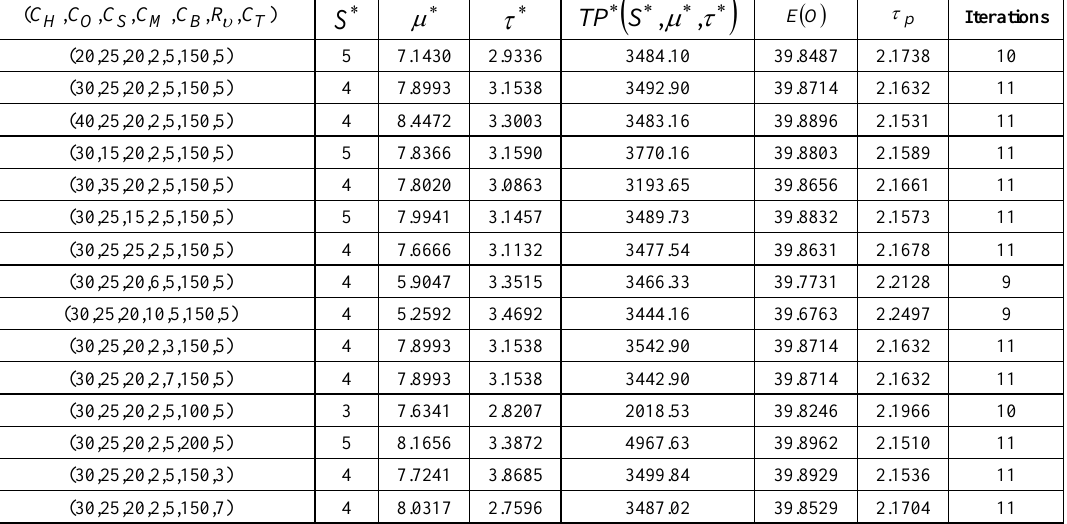
Table 13. Optimal profit analysis wrt unit cost